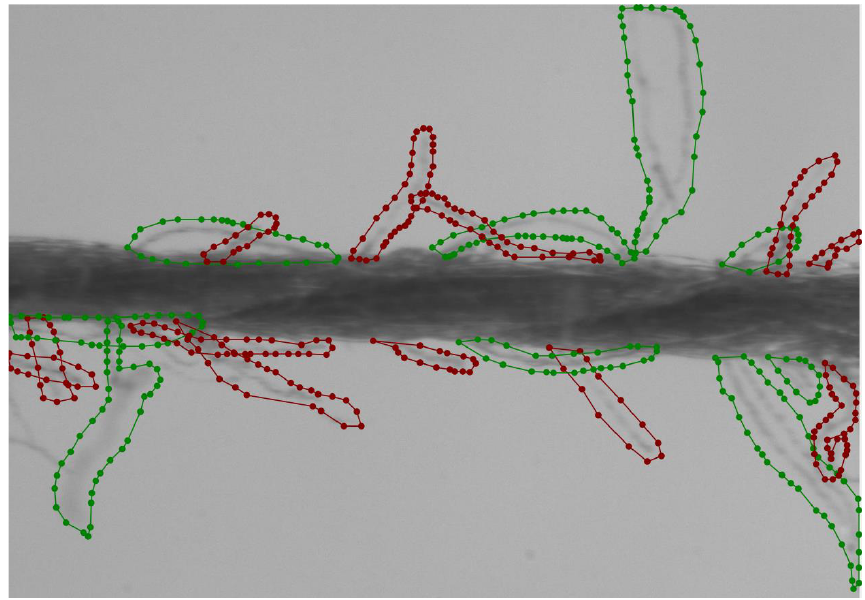
Figure 41. Annotations of an image of the yarn made by LabelME (loop fibers — green color and protruding fibers — red color).